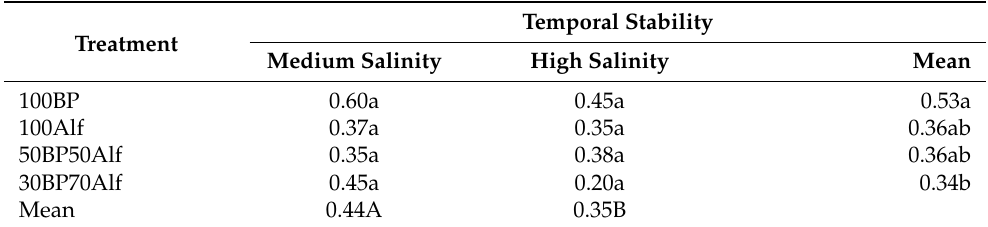
Table 3. Temporal stability of 50–50 and 30–70% blue panicum grass (BP), alfalfa (Alf) mixtures and monocrop dry matter in medium and high salinity from June to December